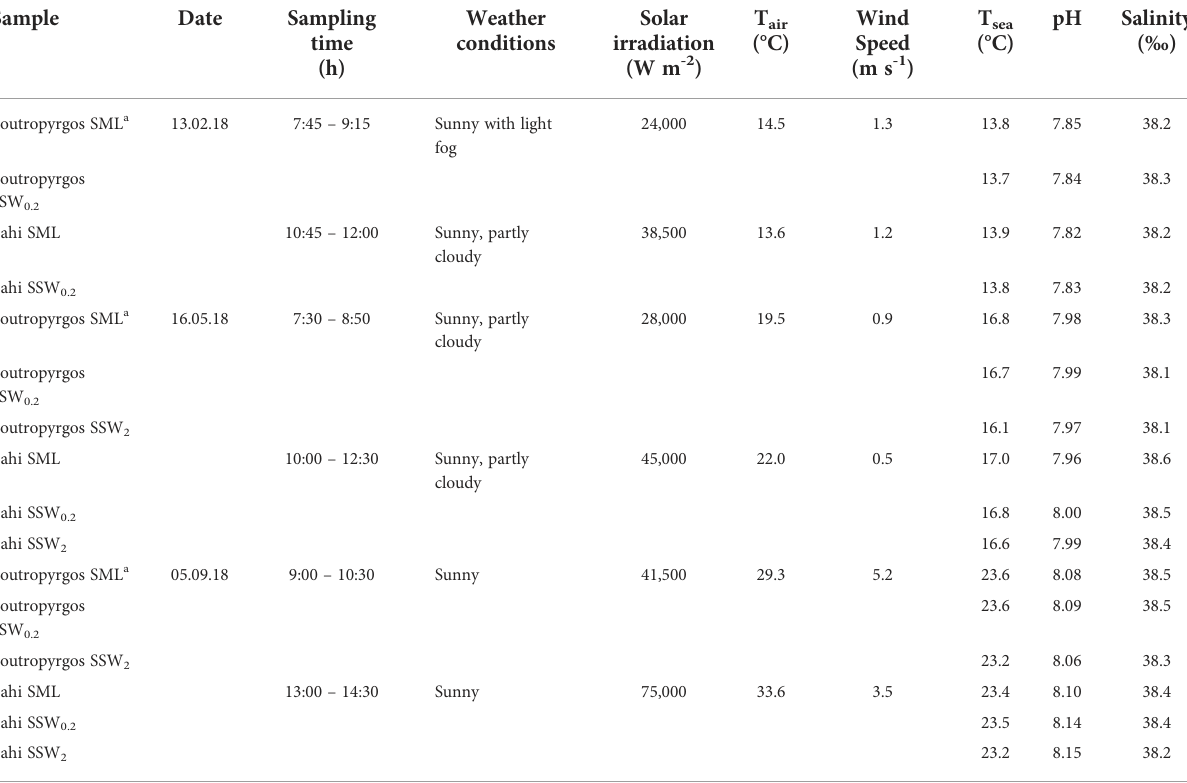
TABLE 1 Sampling dates, environmental and physicochemical conditions.